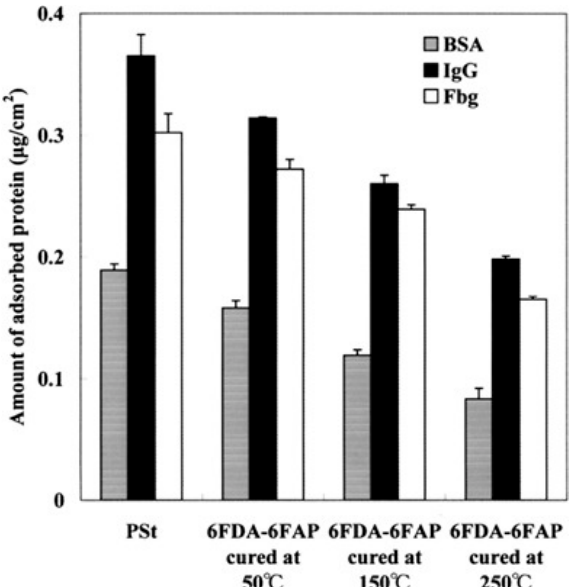
Figure 9. The amount of three adsorbed proteins on the surfaces of the same 6FDA-6FAP fluorinated polyimide membrane cured at three di ff erent temperatures (pH 7.4; polystyrene (PSt) control). Reproduced from [53], with permission from © 2002 John Wiley and